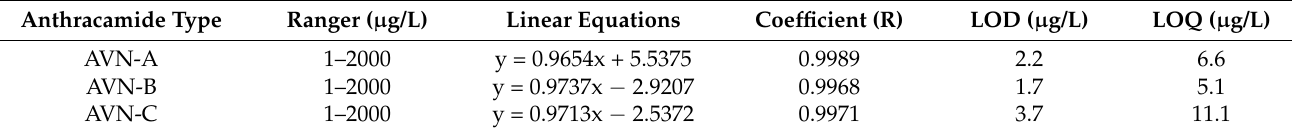
Table 3. Linear equations and LODs and LOQs of the three anthranilamides.